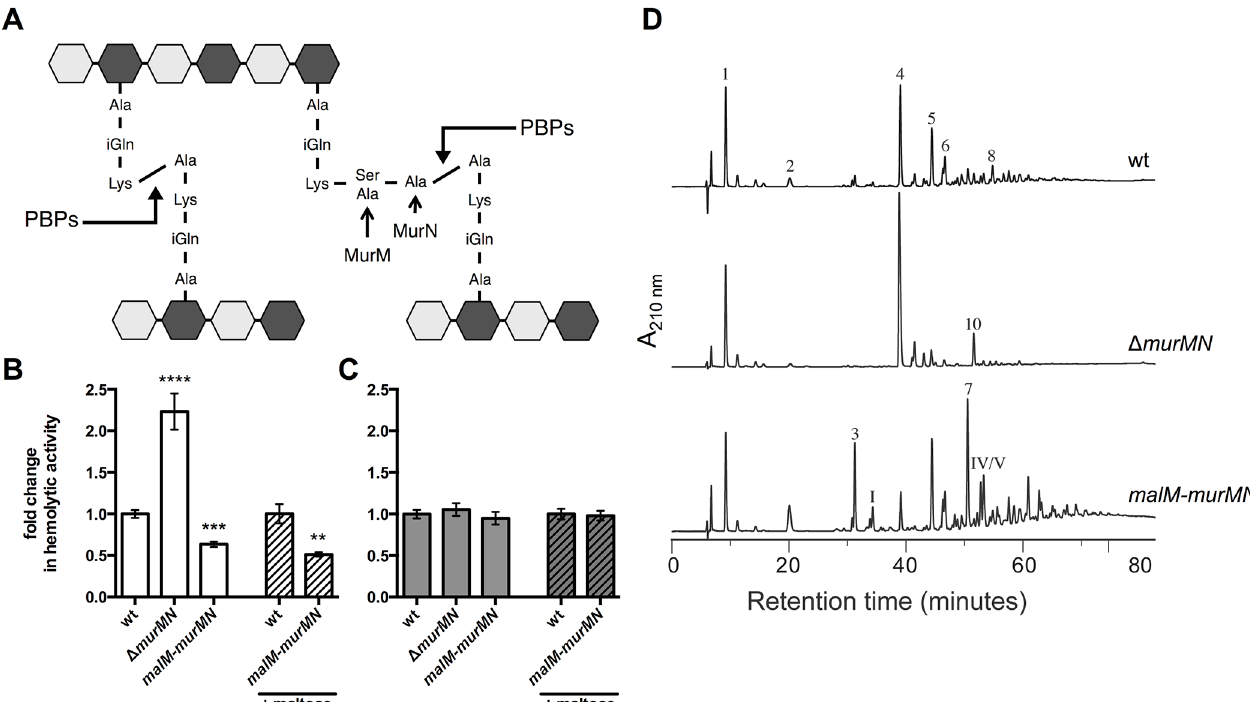
Fig 2. Ply release is altered by murMN -dependent changes in PG composition. (A) Diagram of the basic pneumococcal PG structure highlighting the role of MurM and MurN. PG is a heteropolymer of glycan strands that alternate between N-acetylglucosamine (NAG, light grey hexagon) and N- acetylmuramic acid (NAM, dark grey hexagon) residues crosslinked through short peptides that stem from the NAM moiety. Stem peptides can be linear or branched; the latter form is dependent on MurM and MurN. Penicillin-binding proteins (PBPs) catalyze the crosslinking reaction that links adjacent stem peptides. (B-C) Hemolytic activity of whole cells (B) or sonicated lysates (C) of wildtype (wt) and mutants either lacking murMN or carrying a second copy of murMN under the control of the maltose-inducible promoter were grown with or without 0.8% maltose as indicated. Data are presented as the mean fold change in hemolytic activity compared to the wt in each condition ± SEM of at least four biological replicates. ** p < 0.01, *** p < 0.0005, **** p < 0.0001, Student ’ s t-test. (D) RP-HPLC analysis of stem peptides isolated from purified PG of the wt, murMN deletion, and malM-murMN overexpression strains. PG purification, stem peptide removal, and detection by RP-HPLC were performed as described in Materials and Methods . Peptides were detected by their absorption at 210 nm. The peptide structures of indicated peaks are outlined in S4 Fig.